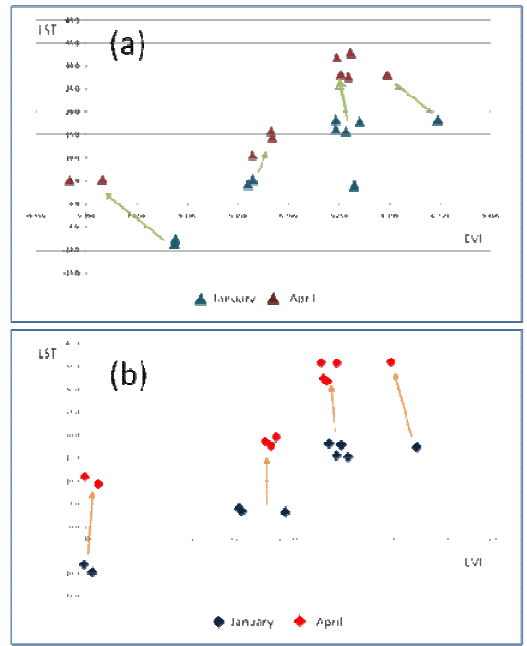
Fig.5. Biomass (a1,a2), Carbon (c1,c2) of Cold area Tall Grass Vegetation ( south of Sangla, ‘ potentially resilient patches of DGVM (Ver 2.54) . (Units : Mg time in years). Soil Organic M Wood and Grass Pools produc Shown in different fractions. C emission and NEP shown as